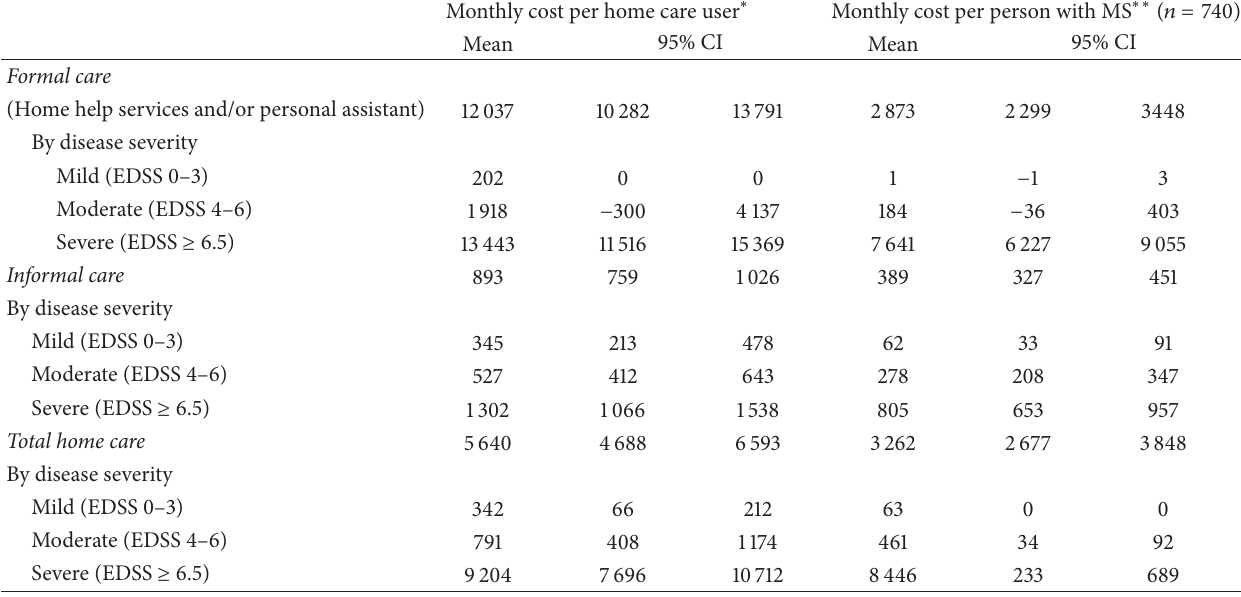
Table 4: Estimated monthly costs for formal and informal care per home care user and per person with MS in the sample (euro, 2012 prices).